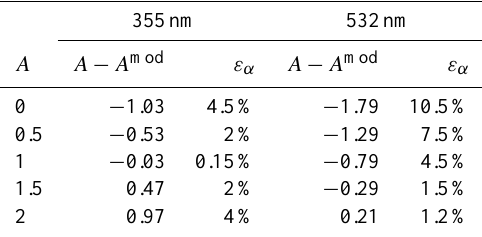
Table 2. Uncertainties of extinction ε α at 355 and 532nm for differ- ent values of Ångström exponent A chosen in computations. Results are shown for m = 1 . 45 − i 0 .